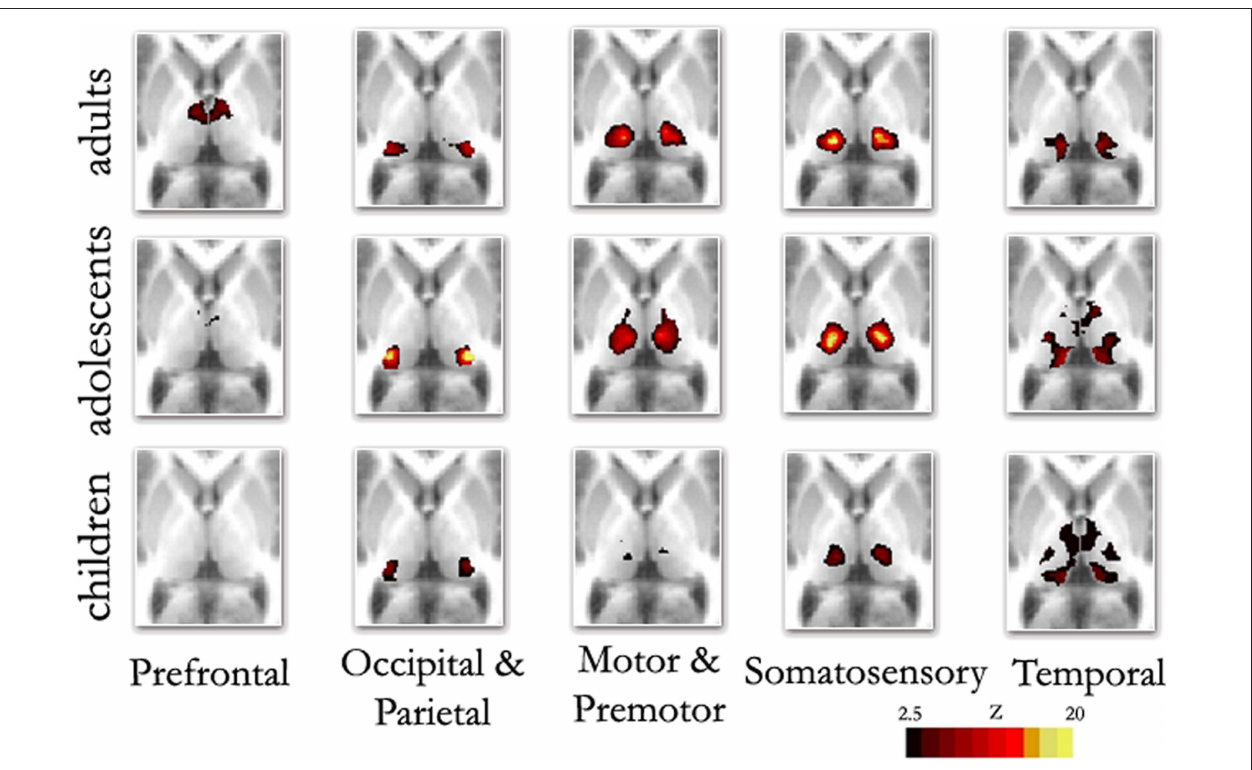
FIguRe  | Fixed effects functional mapping of the thalamus for each cortical ROI, in each age group (Children, Adolescents, Adults). This qualitative comparison appears to show substantial change over development regarding the thalamo-cortical functional interactions. The functional neuroanatomy of the adult group is quite similar to previous publications